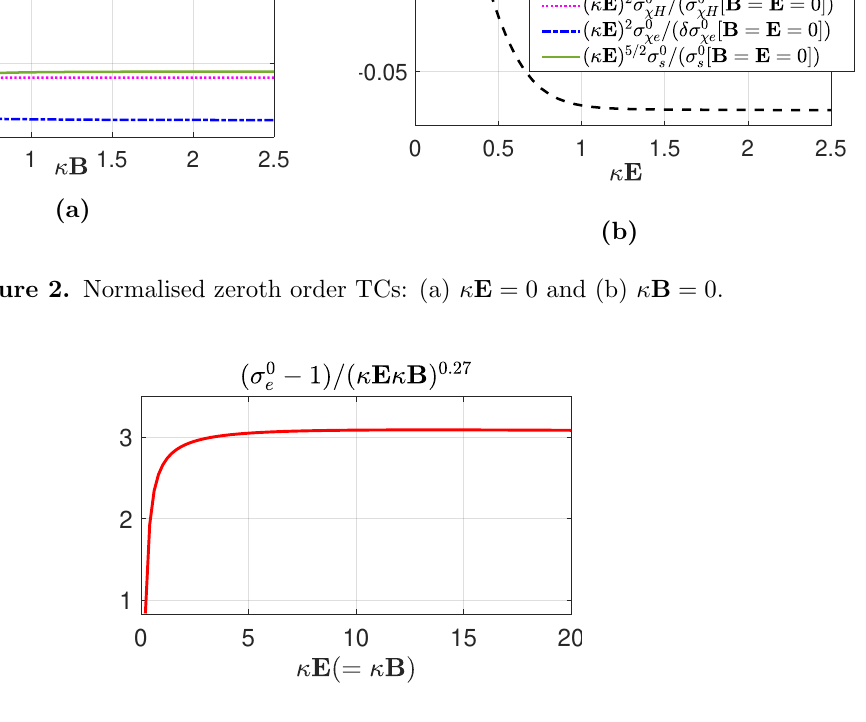
Figure 3. (cid:27) 0 functions of (cid:20) B and (cid:20) E (on the slice of (cid:20) B = (cid:20) E ). e